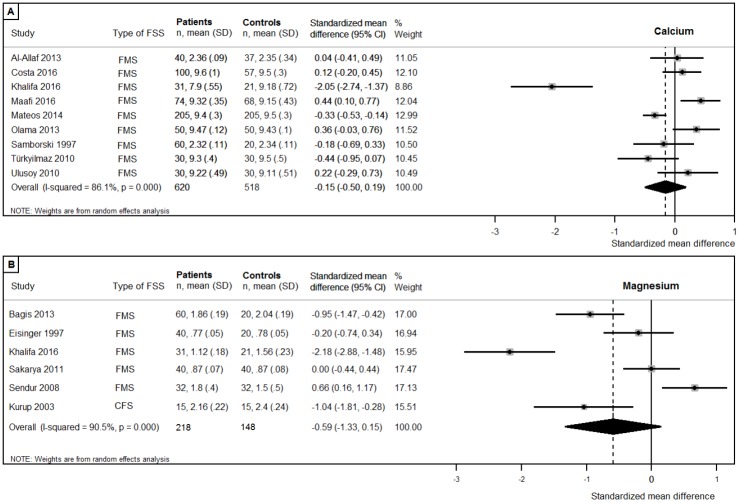
Forest plots of studies investigating minerals.(A) Calcium; (B) Magnesium.